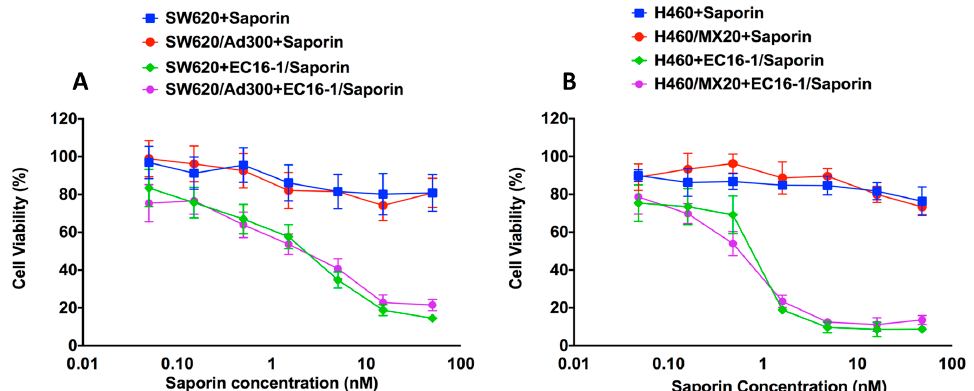
Figure 2. Cytotoxicity of saporin or EC16-1 / Saporin in parental and ABCB1- or ABCG2-overexpressing cells. The MTT assay was used to determine the e ff ect of saporin or EC16-1 / saporin on the viability of parental SW620 and ABCB1-overexpressing SW620 / AD300 cells after 72 h of incubation ( A ). E ff ect of saporin or EC16-1 / saporin on the viability of parental NCI-H460 and ABCG2-overexpressing NCI-H460 / MX20 cells ( B ). The lines represent the mean of triplicate determinations ( n = 3). The error bars represent the SD.